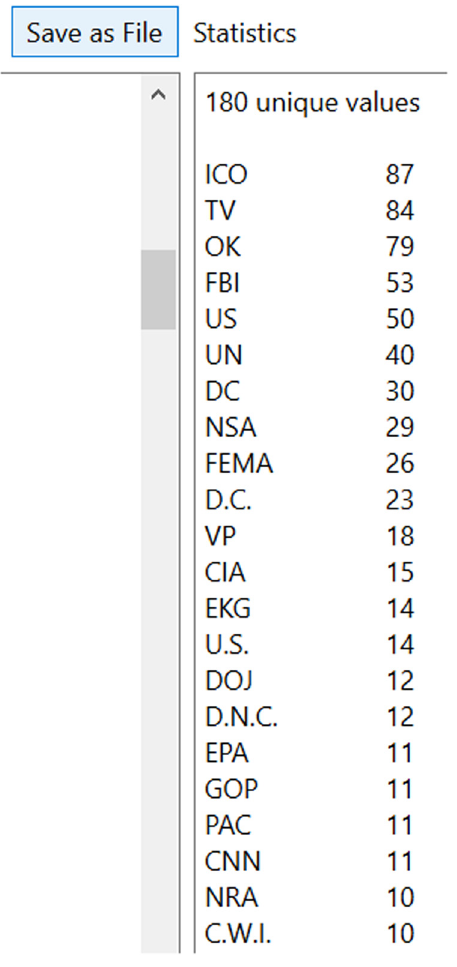
Figure 2: SRT Manager, unique values and total number of